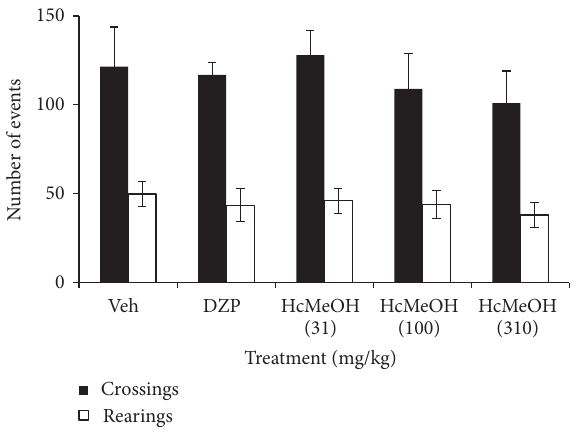
Figure 2: Effect of oral administration of Heteropterys cotinifolia methanolic extract on the number of total crossings and rearings of ICR mice exposed to OFT. ∗ 𝑃 < 0.05 with ANOVA followed by a post hoc Dunnett test (mean ± S.D.). Veh, vehicle; DZP, diazepam; HcMeOH, methanolic extract of Heteropterys cotinifolia.